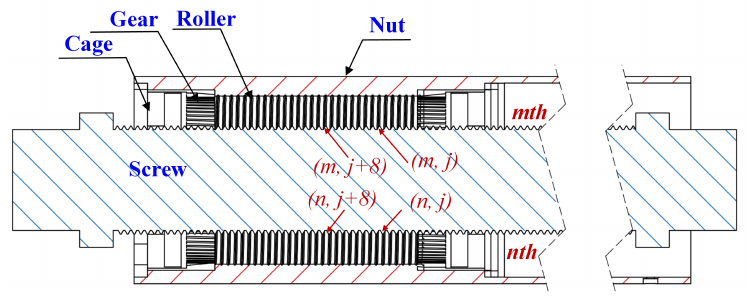
Figure 4. The threads number of each roller for the downhole robot